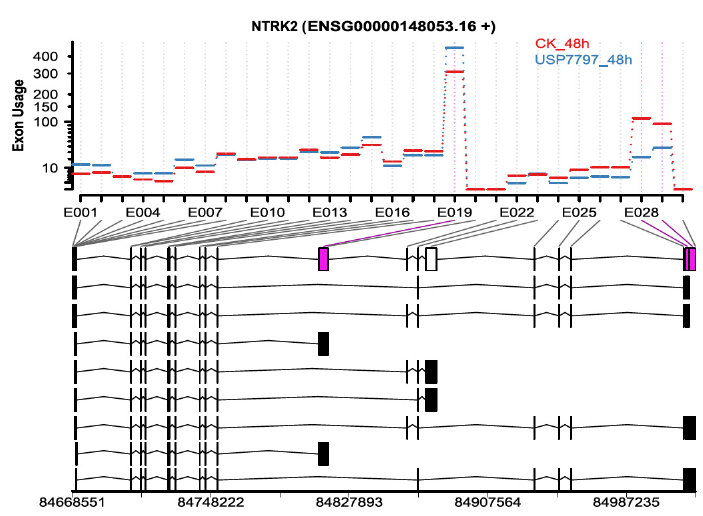
Figure 5. Representative plot showing differential exon usage between samples treated with USP7797 for 48 h and those treated with DMSO vehicle for 48 h. Significantly di ff erentially used exons 19, 28, for 48 hours and those treated with DMSO vehicle for 48 hours. Significantly differentially used exons and 29 are in 19, 28, and 29 are in purple.